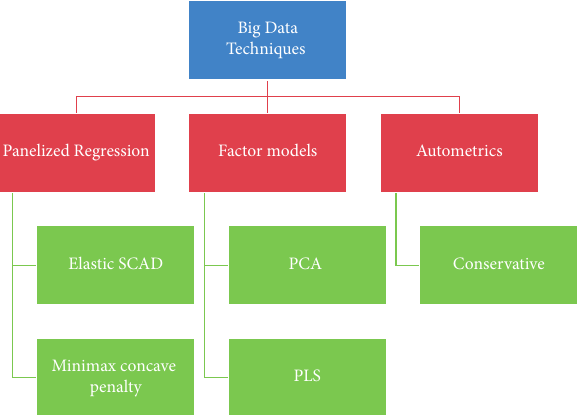
Figure 2: Methods of big